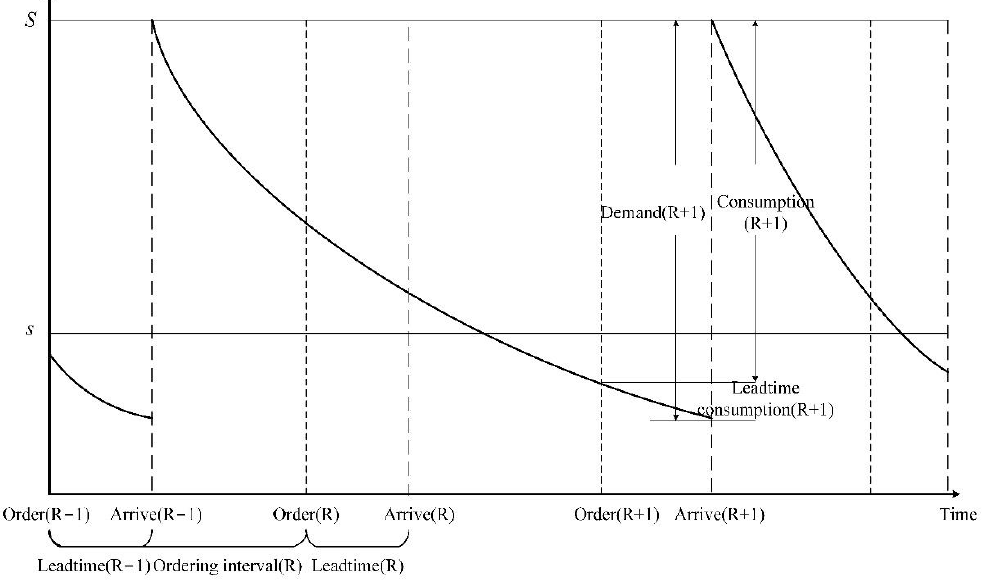
Figure 2. (T, s, S) inventory control policy.